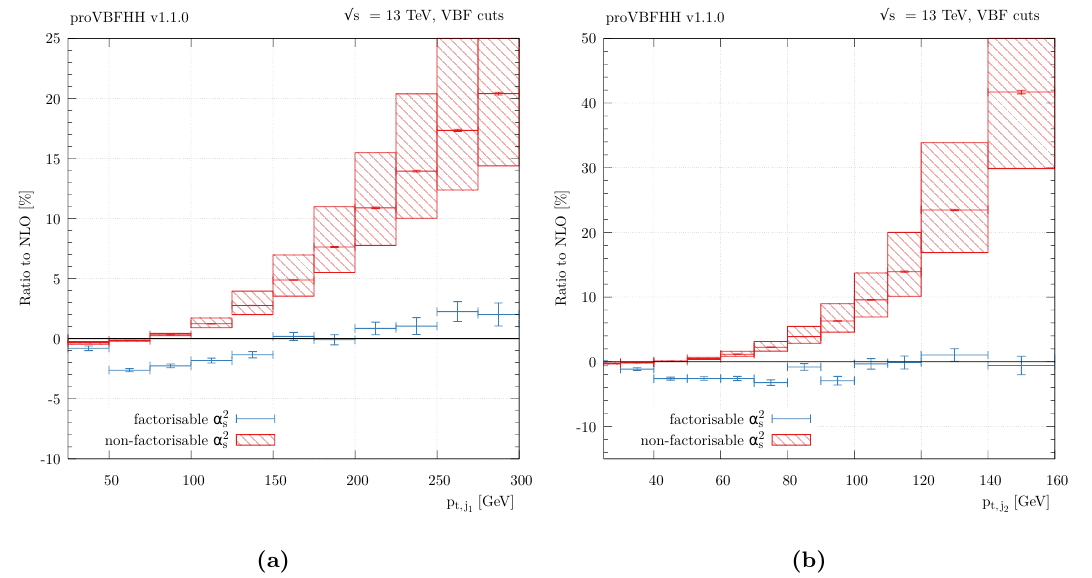
Figure 14. Kinematic distributions for Higgs pair production through VBF under the cuts of section 3.1. (a) transverse momentum of the hardest jet (b) transverse momentum of the second hardest jet. In red we show the non-factorisable (cid:11) 2 correction and in blue we show the factorisable s one. Both are normalised to the NLO cross